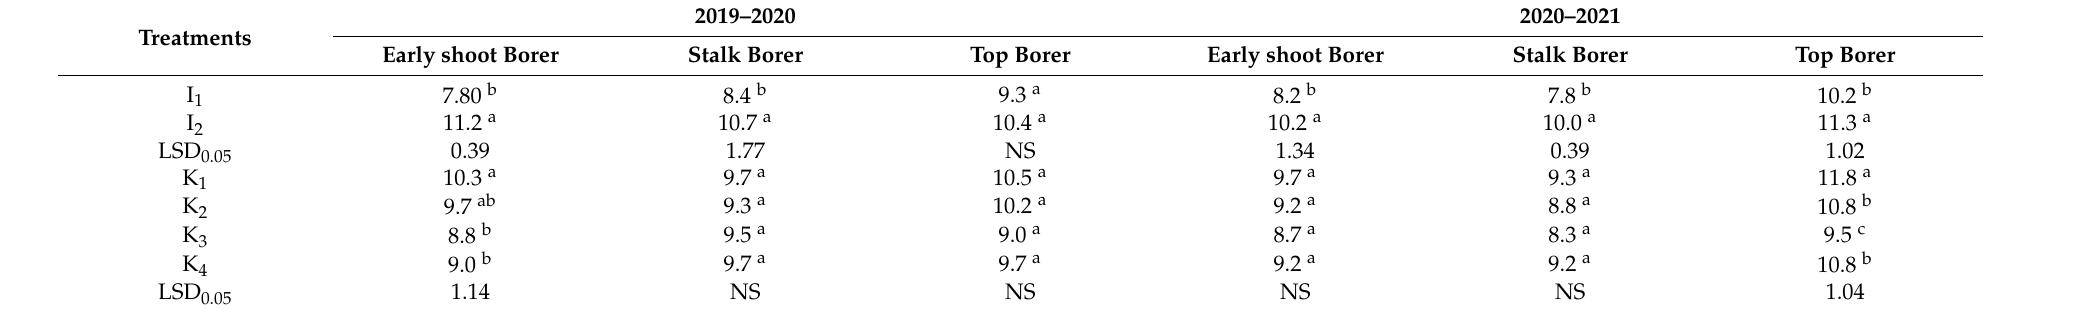
Table 11. Percent incidence of insect pests as a function of irrigation and potash